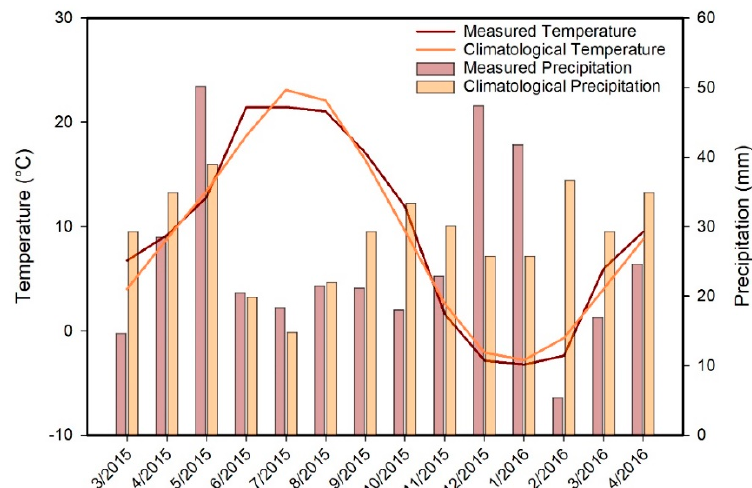
Figure 2. Average monthly temperature and precipitation during the study period compared to the climatology, i.e., the long-term (1981–2010) monthly averages for Utah Lake near Lehi [28]. Temperature and precipitation amounts were generally similar to the long-term average, but May and December 2015 and January 2016 were wetter, whereas February 2016 was drier than average.